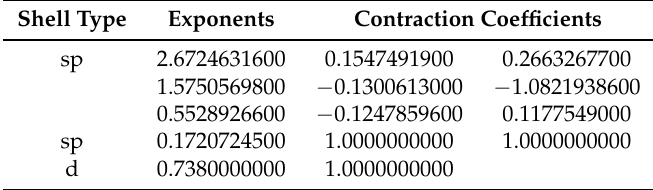
Table A14. Parameters of the cc-DZVP basis set of Argon.